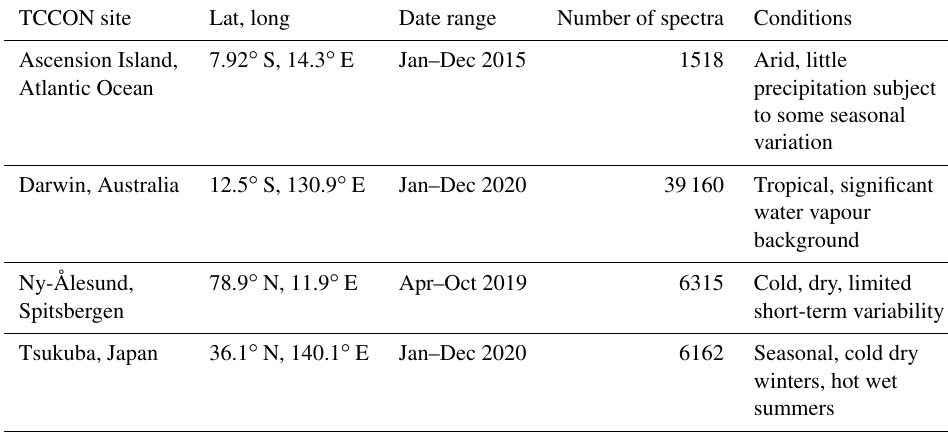
Table 1. TCCON sites used in this